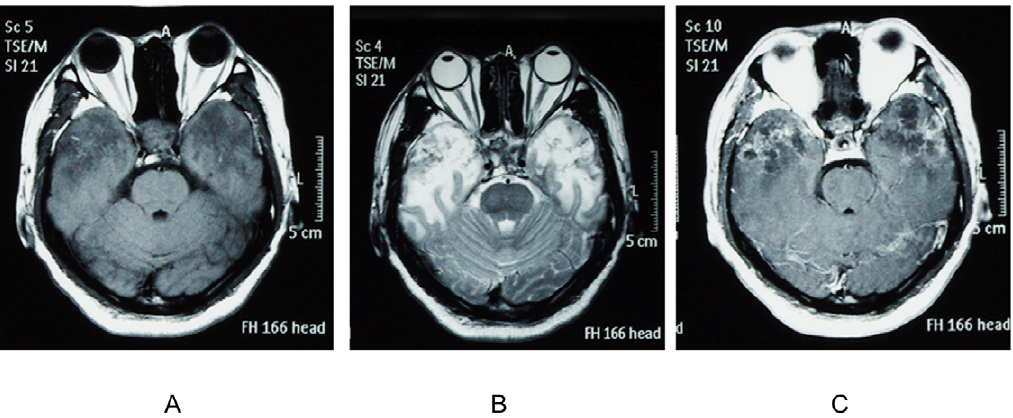
Figure 1. The brain MRI scan of a patient with RI. (A) The axial T1-weighted imaging showed relatively low-signal-intensity lesions in the bilateral temporal lobes. (B) The T2-weighted imaging revealed high-signal-intensity lesions in the bilateral temporal lobes. T1-weighted image after contrast administration (C) showed irregular edge contrast enhancement of the bilateral temporal lobes.